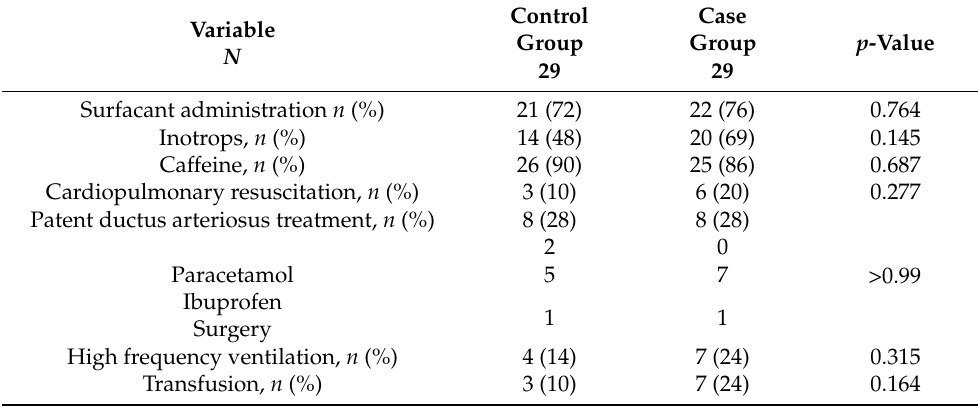
Table 3. Therapeutic interventions in neonates of control and case group